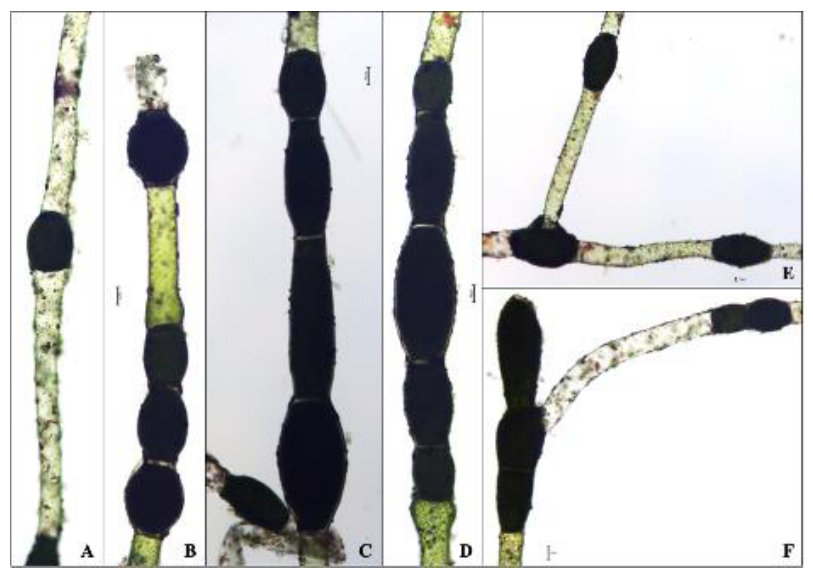
Figure 3. Mature, heterosporous akinetes of the principal filament or of germinated branches of Pithophora roettleri at 100× magnification. ( A , B , E , F ) Interspersed akinetes. ( B – D , F ) Rows of akinetes. ( F ) Terminal cells bearing triple akinetes. ( E , F ) Akinetes with germinating branches bearing akinetes. Scale bar = 10 µm. Branches were irregularly formed throughout the thallus. Fully germinated branches developed from intercalary (Figure 3E) or from the terminal (Figure 3F) akinetes. Inter- rupted germination of branches into akinetes were also observed with some exhibiting a beak-like form and some divided by a transversal cell wall (Figure 5). Because the branch process in Figure 5E was more developed, the elongation of its branch assumed a 45 angle to the principal filament while an akinete was formed on its upper end. Branches were also observed forming below the upper cell wall of a supporting cell (Figure 5C,D). Rhi- zoidal cells, zoospores, and zygotes were not observed.